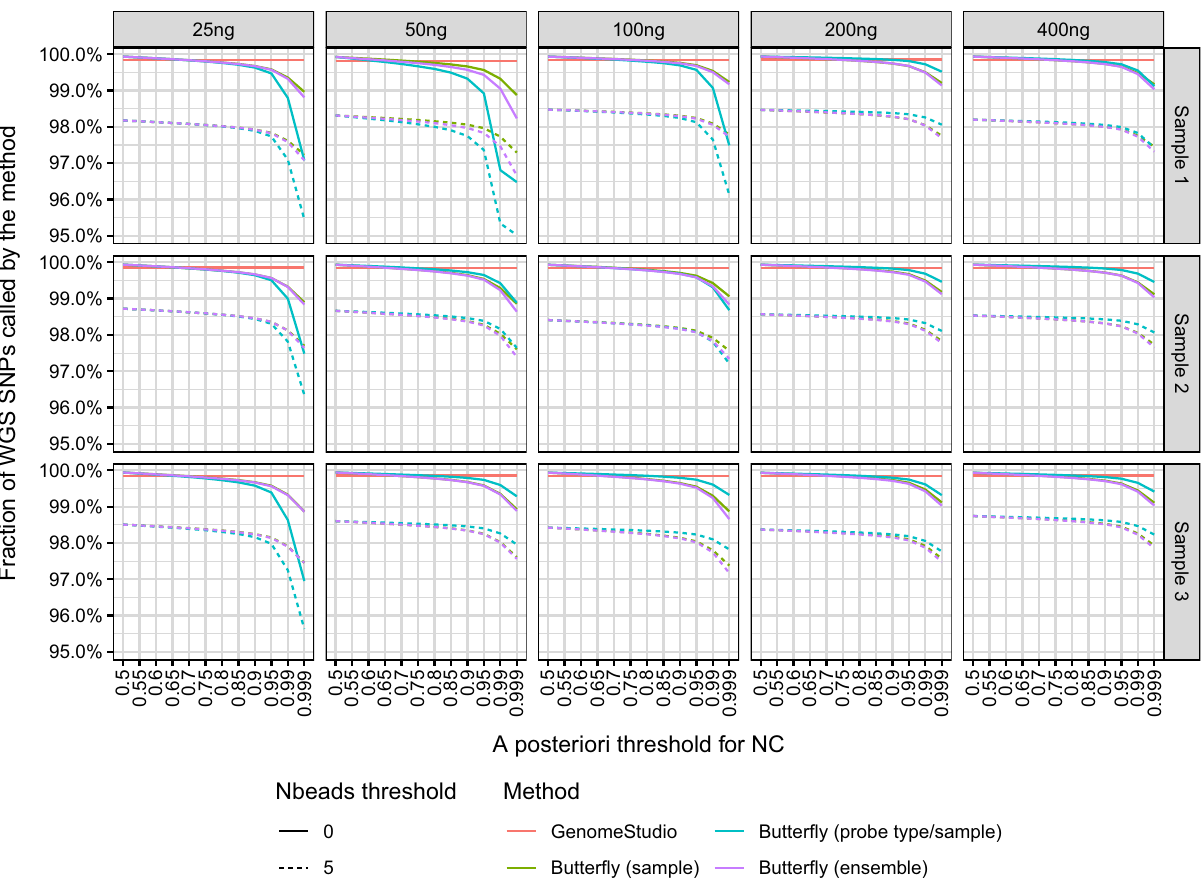
Figure 4. Fraction of SNP calls with the three variants of the butterfly method and GenomeStudio. The butterfly method gave a no-call (NC) if either the maximal a posteriori threshold of belonging to a SNP cluster was too low or if the mean signal intensity of either allele A or B (A/B nomenclature) was based on too few beads (both thresholds shown). The call-rate was always above 95% and for a posteriori thresholds below 99%, the call-rate were very often above